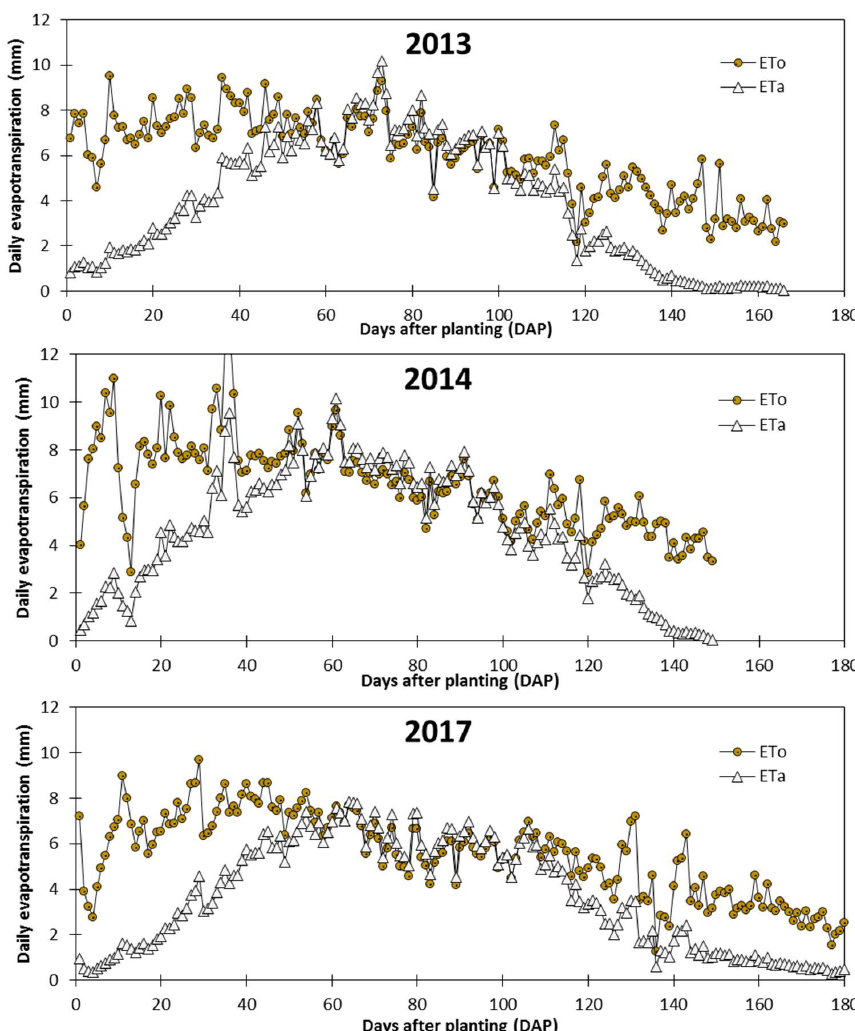
Figure 2. Trends in the daily reference evapotranspiration and maize actual evapotranspiration during the growing season 2011, 2012, 2013, 2014 and 2017.